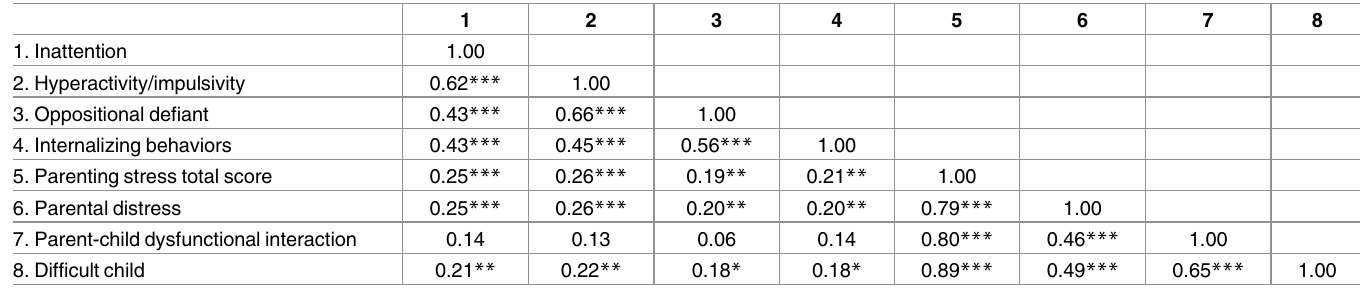
Table 4. Correlation matrix for informant discrepancies and parenting